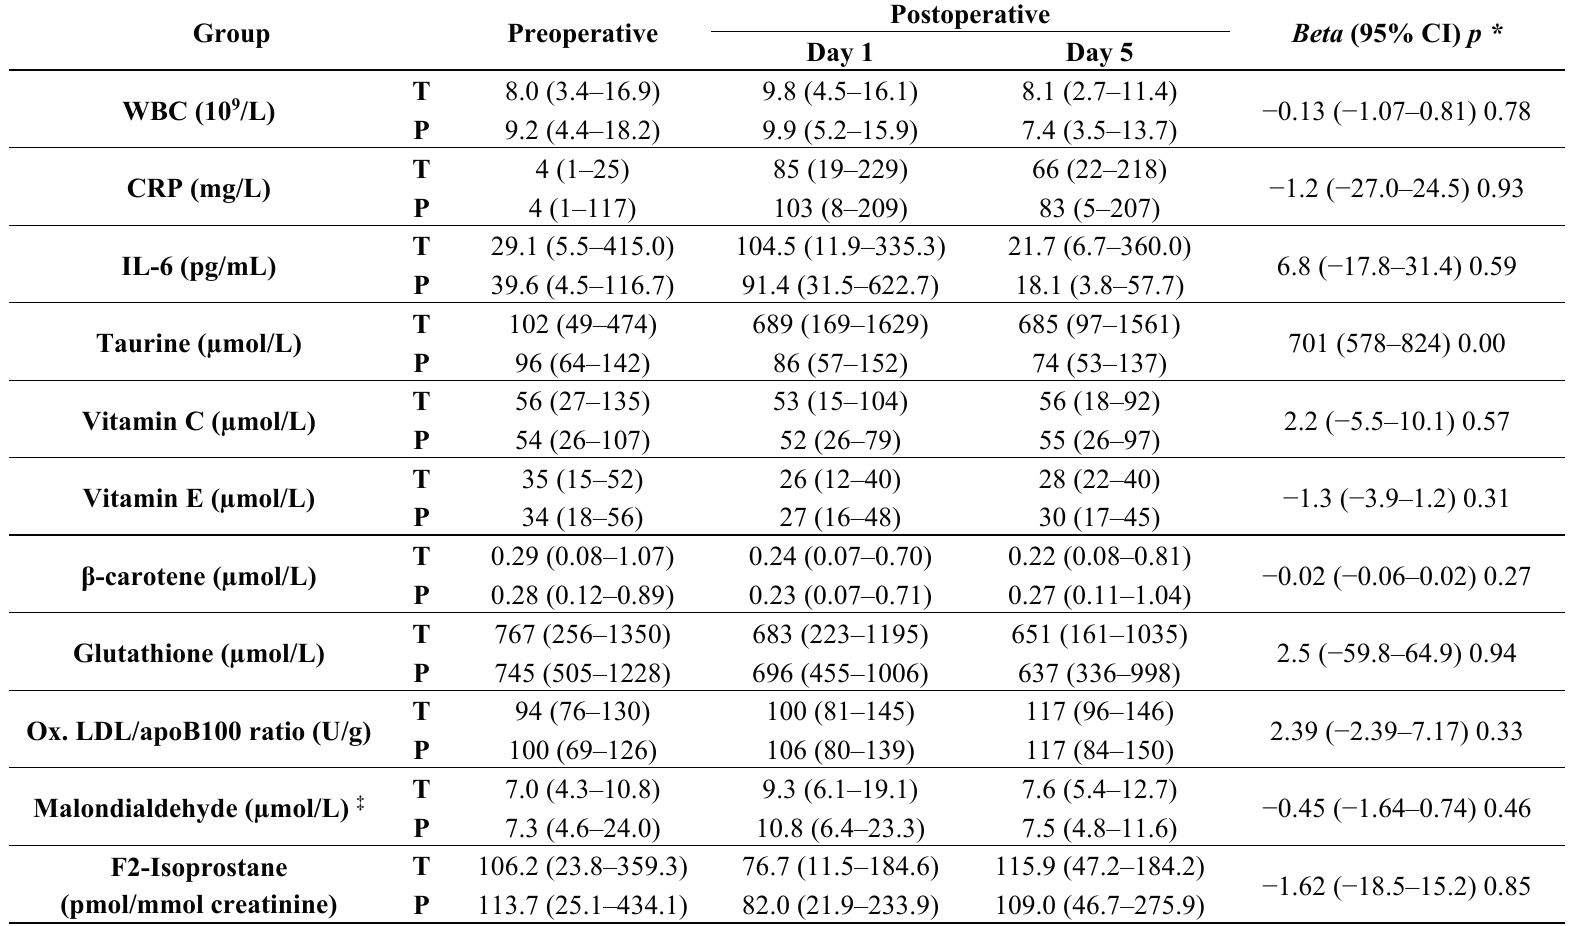
Table 2. Surgical stress response in a sub group of 60